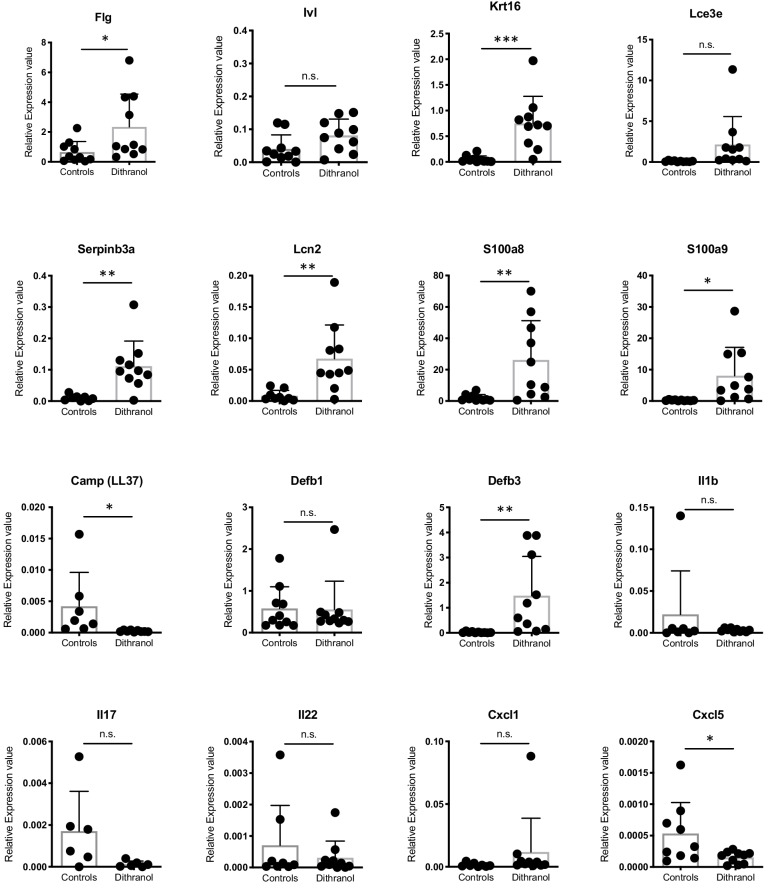
Gene expression analysis by RT-PCR of keratinization markers (Flg, Ivl, Krt16, Lce3e, Serpinb3a), AMPs (Lcn2, S100a8, S100a9, Camp, Defb1, Defb3) and inflammatory markers (Il1b, Il17, Il22, Cxcl1, Cxcl5) of dithranol- and vehicle-treated murine tail skin.Bars represent mean ± SD (n = 10) of relative expression values (deltaCT) normalized to Ubc. Unpaired t-test was used for statistics (n.s. = not significant) Flg, filaggrin; Ivl, involucrin, Krt16, keratin16; Lce3e, Late Cornified Envelope 3e; Camp, Cathelicidin Antimicrobial Peptide; Defb1, Beta-Defensin 1; Defb3, Beta-Defensin 3; Il1b, Interleukin one beta; Il17, Interleukin 17; Il22, Interleukin 22; Cxcl1, C-X-C Motif Chemokine Ligand 1; Cxcl5, C-X-C Motif Chemokine Ligand 5.